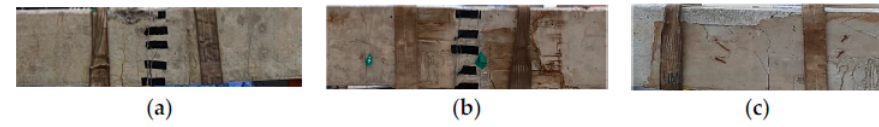
Figure 12. Failure of specimens in the midspan: ( a ) CRC; ( b ) PCM-A; ( c ) PCM-B.